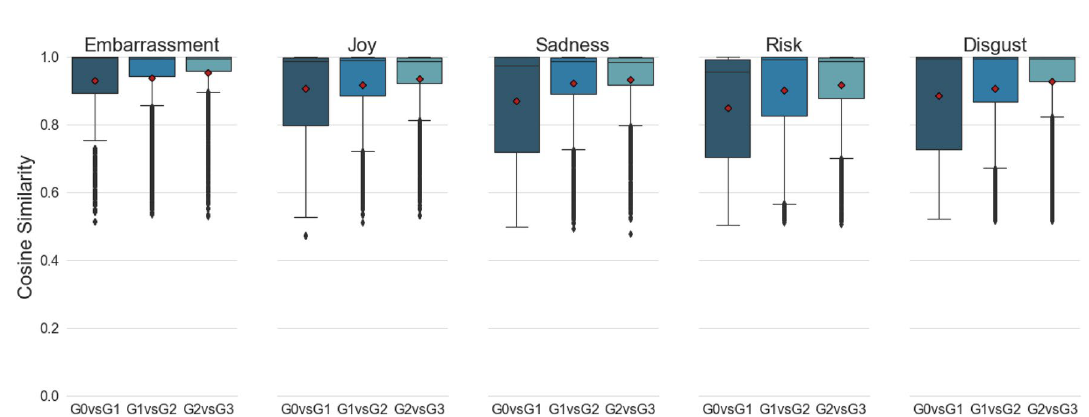
Figure 4. Boxplots of SET2 cosine similarity (CS) scores comparing stories between consecutive generations along the serial path of retelling. Individual means are represented by the red diamonds, and outliers are represented by a black